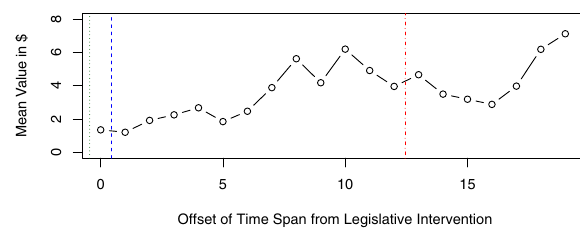
Fig. 14 Incentives mean transaction value. Temporal representation of the mean value of incentives transactions after span 0 that agents are getting for using non-cash payments. This comes from the 1 or 2% VAT refund for non-cash transactions. These values increases over the life time of the MM